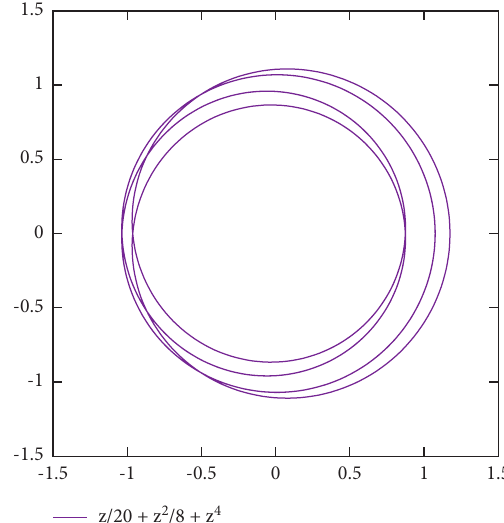
Figure 10: Example of curve with 3 pairs in P